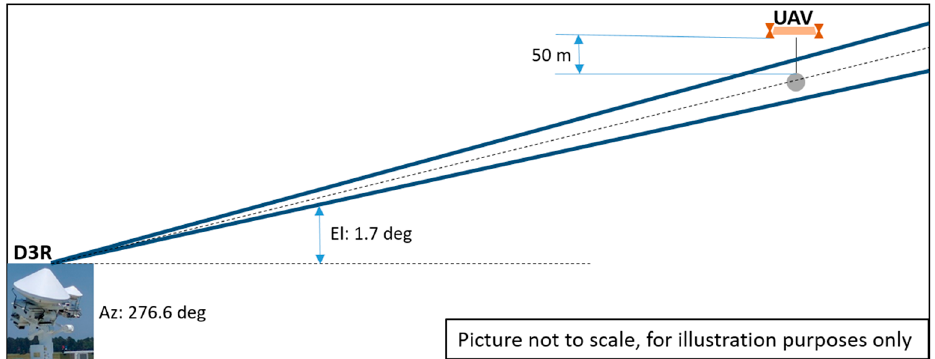
Figure 4. Geometry of the D3R calibration experiment using sphere suspended from UAV.